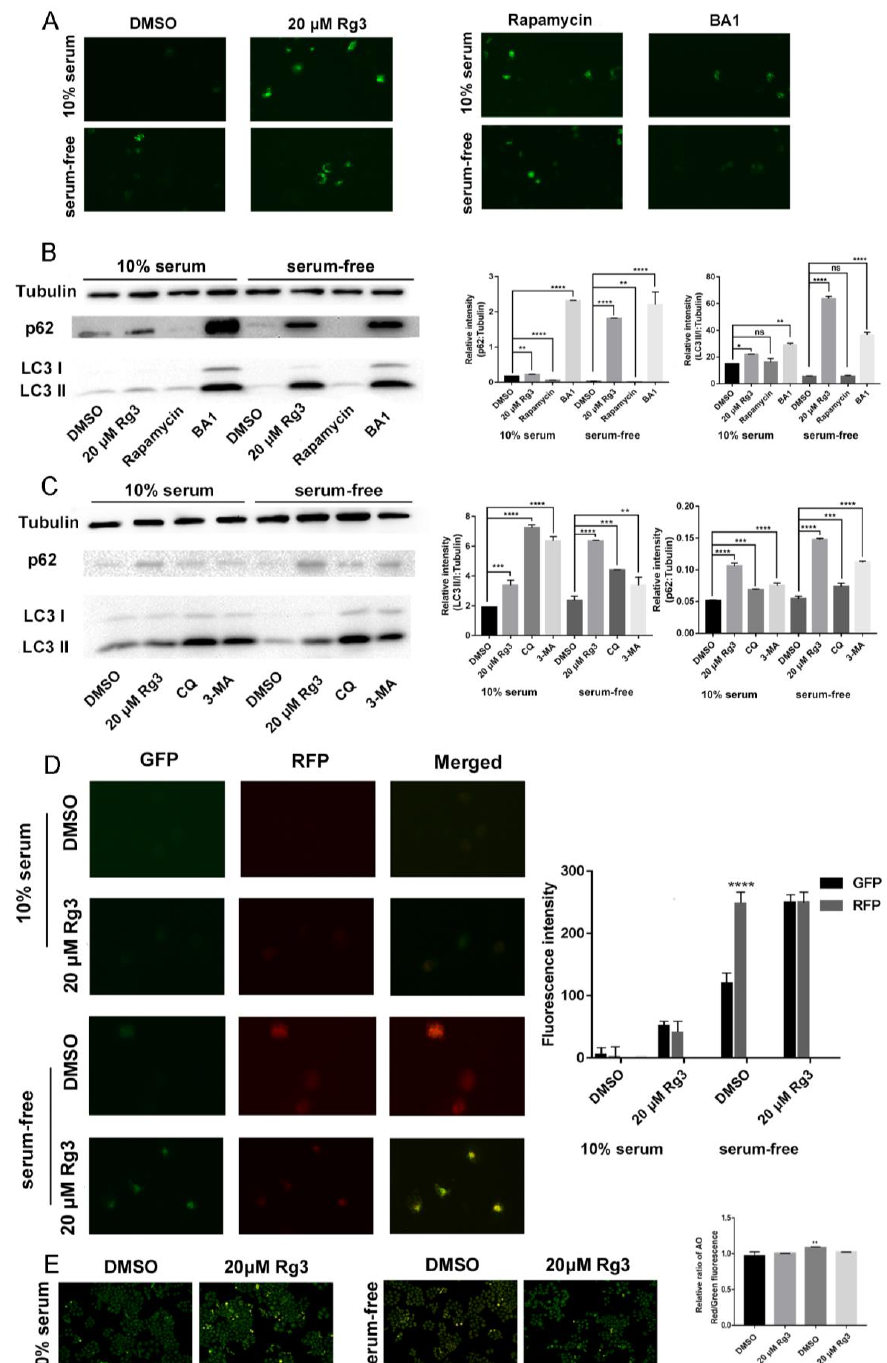
Figure 4. 20( S )-GRg3 represses starvation-induced autophagic flux. ( A ) Hela cells were transfected with GFP-LC3 and then treated with DMSO, 20( S )-GRg3, 100 nM rapamycin, or 100 nM BA1 after 24 h in normal or serum-free media. After 24 h, the cells were observed under a fluorescence microscope. ( B ), ( C ) HeLa cells were treated with DMSO, 20( S )-GRg3, or autophagy regulators in the presence or absence of serum and harvested after 24 h. The proteinexpression of p62 and LC3 were evaluated by a western blotting assay. ( D ) HeLa cells were transiently transfected with GFP-mRFP-LC3 and cells were treated with DMSO or 20( S )-GRg3 in the presence or absence of serum and harvested for 24 h. At the end of treatment, cells were observed for the change of both green and red fluorescence using a confocal microscope. ( E ) Acidic vesicular organelles were examined by incubating Hela cells with acridine orange followed by fluorescence microscopy. * p < 0.05, ** p < 0.01, *** p < 0.001, **** p < 0.0001, ns >